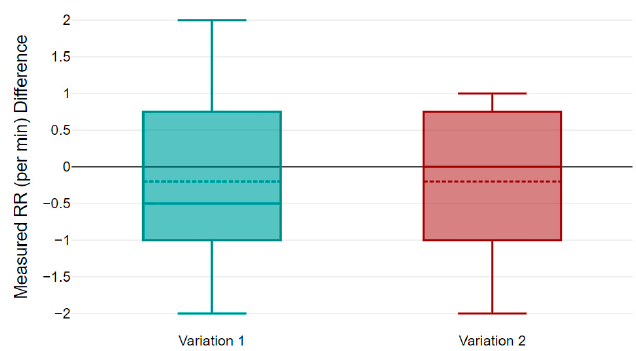
Figure 19. Boxplot of variation 1 and 2 of measured data.